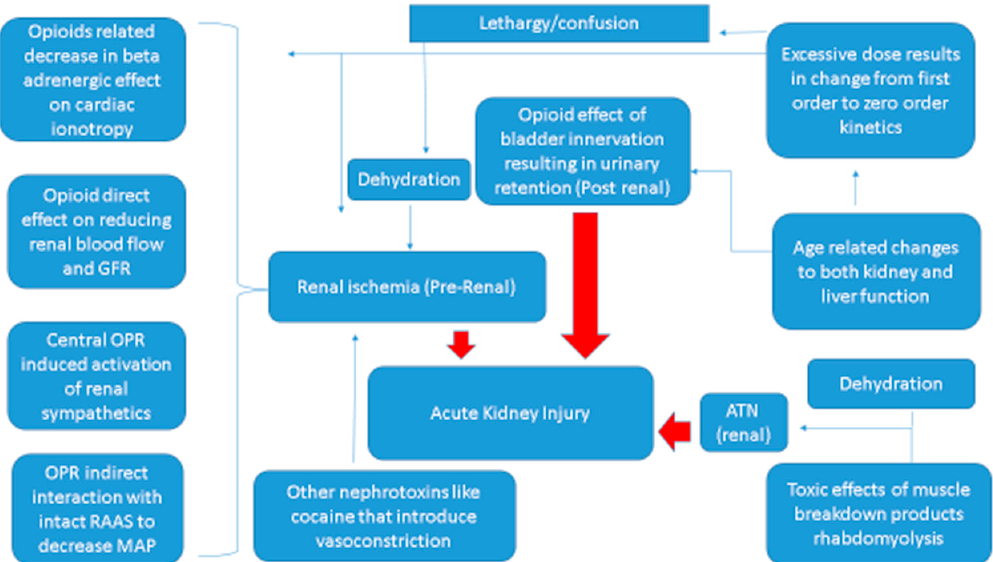
Figure 1. Mechanism of opioid-related kidney failure: pre-renal, acute tubular necrosis and post-renal failure. GFR: glomerular filtration rate; MAP: mean arterial pressure; OPR: opioid peptide receptors; RAAS: renin–angiotensin–aldosterone system; ATN: acute tubular necrosis. Red arrows show the final pathway to acute kidney injury.